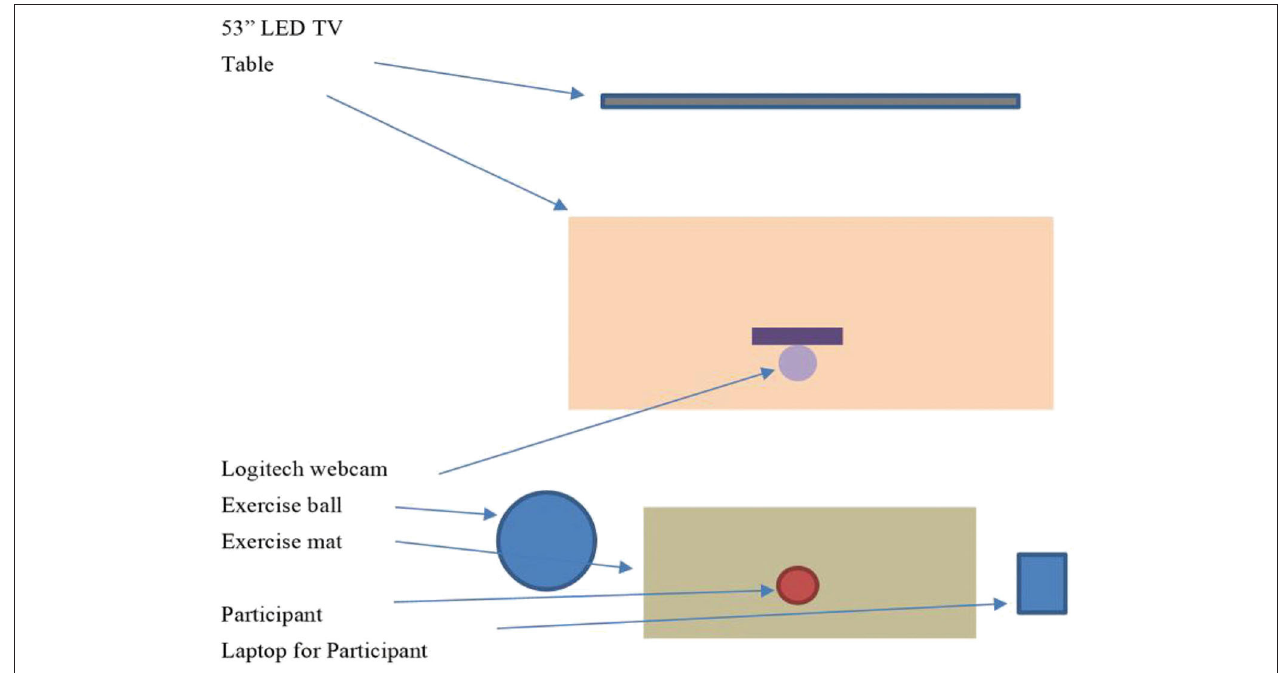
FIGURE 1 | Experimental setup for Group